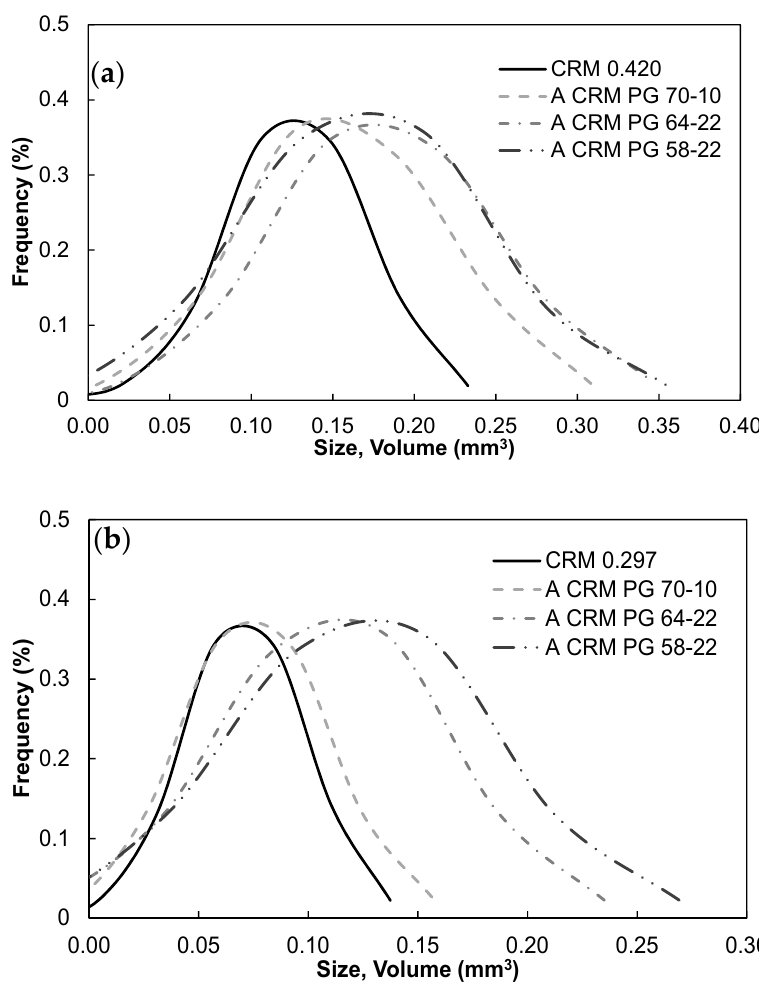
Figure 7. Particle volume distribution of both pre- and post-blended rubber particles retained on sieve ( a ) 0.420 mm and ( b ) 0.297 mm (*A CRM PG (70-10, 64-22, 58-22) represent the distribution of the post-blending particles). (Adapted with permission from ref. [19], Copyright 2017 Elsevier).